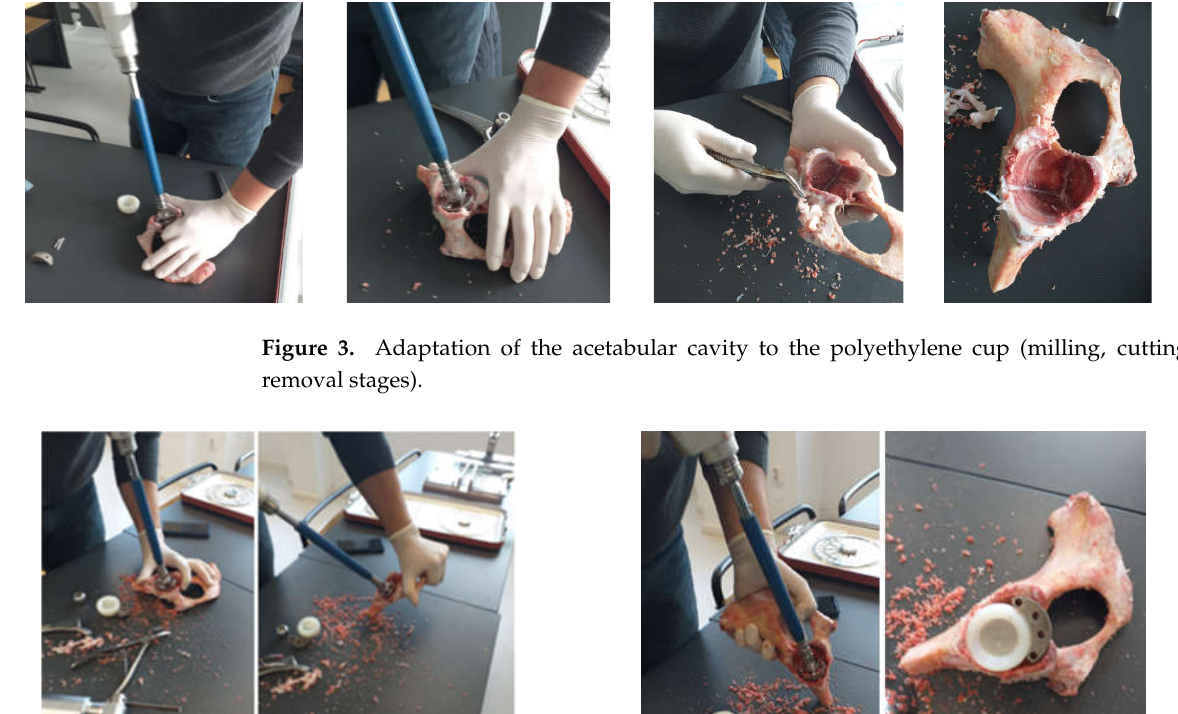
Figure 4. Steps to make the cavity for the titanium augment.